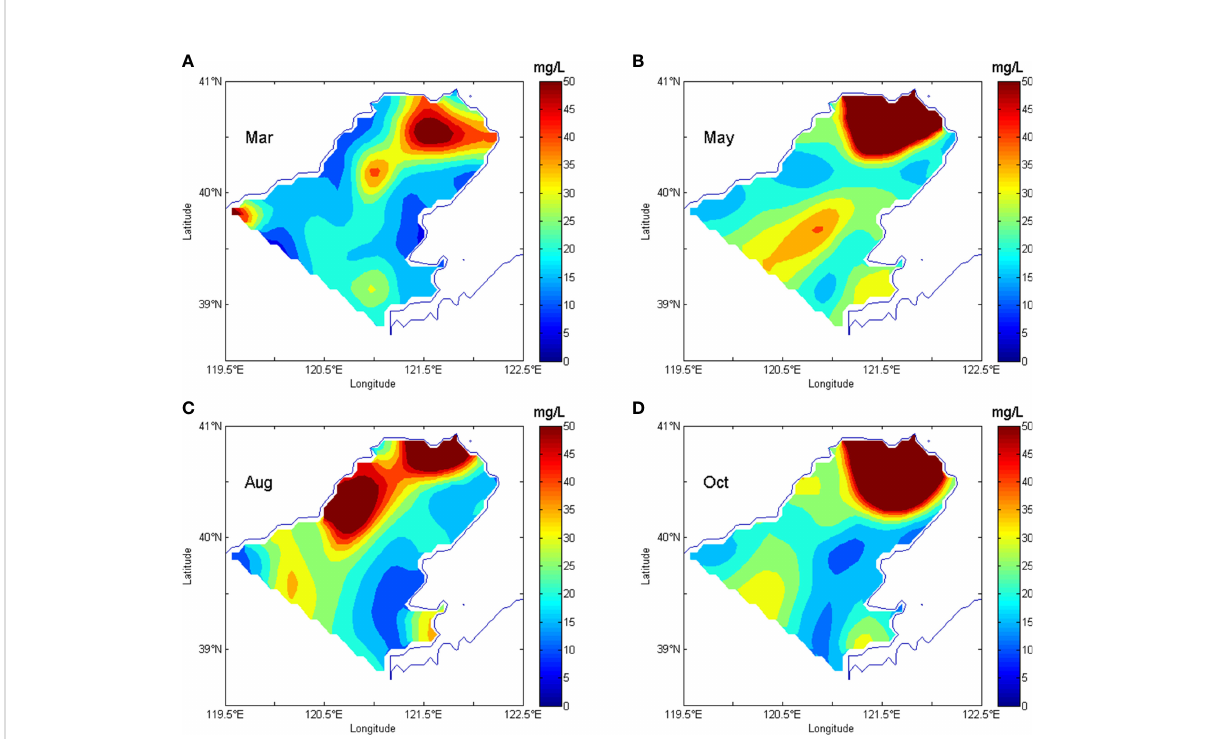
FIGURE 5 Interpolated distributions with dynamical constraint of SPM concentrations in the Liaodong Bay. (A) is the distribution obtained by dynamically constrained interpolation based on SPM observations in March 2015. (B – D) are the interpolated distributions of May, August and October 2015,